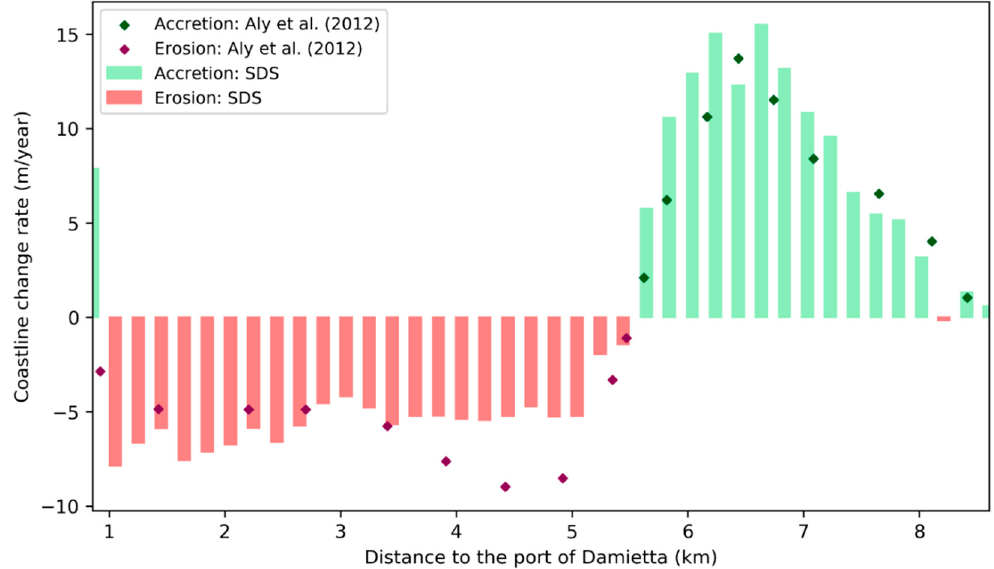
Figure 14. Spatial accretion (in green) and erosion (in red) patterns expressed in coastline change rates (m/year) for shore-normal transects eastward of Damietta port between 1993 and 2000. The results of Aly et al. [18] are represented by dots and our results are represented by bars.